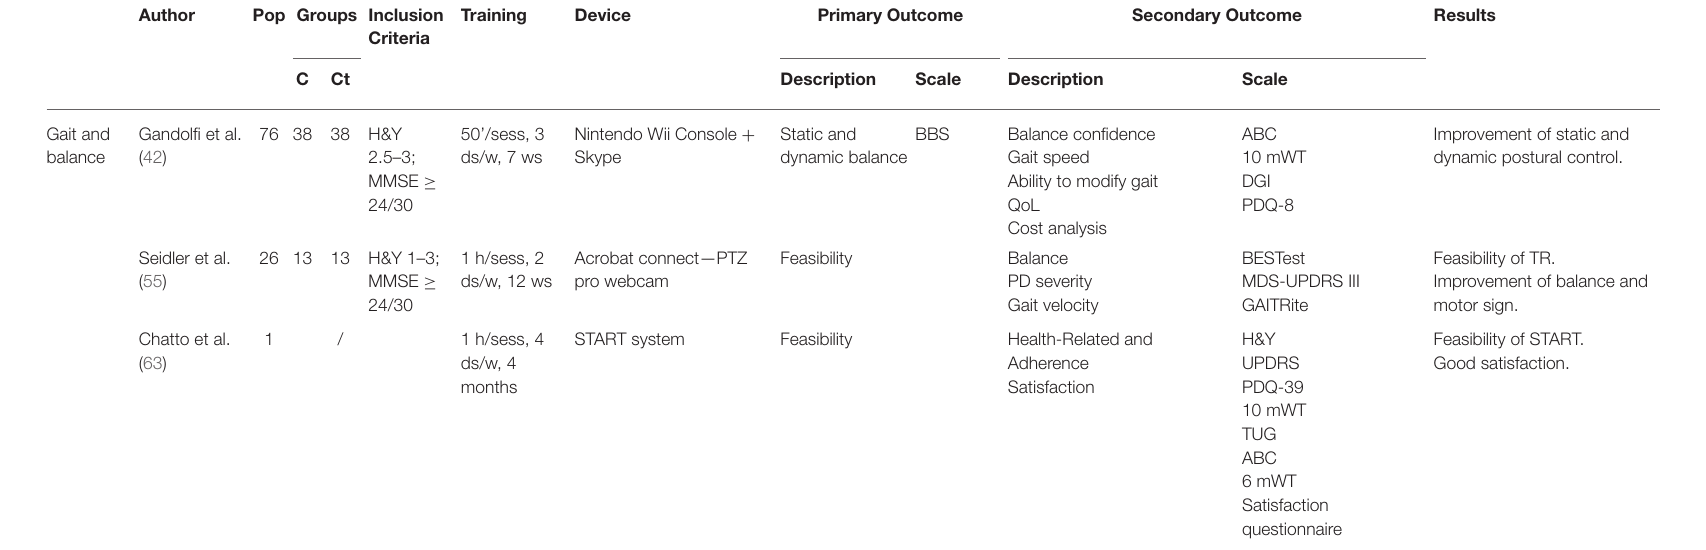
TABLE 5 | Description of the articles included focused on “Gait and Balance” as primary